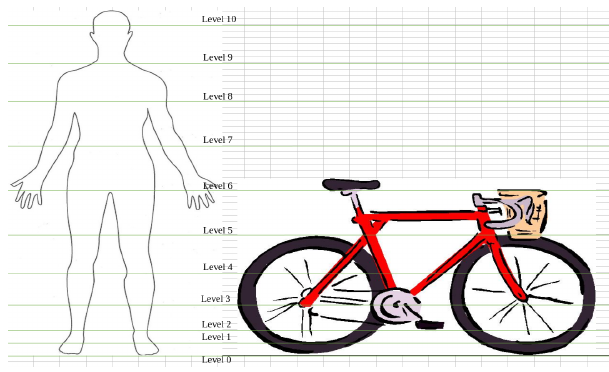
Figure 2. The figure shows the annotation strategy for object Person and